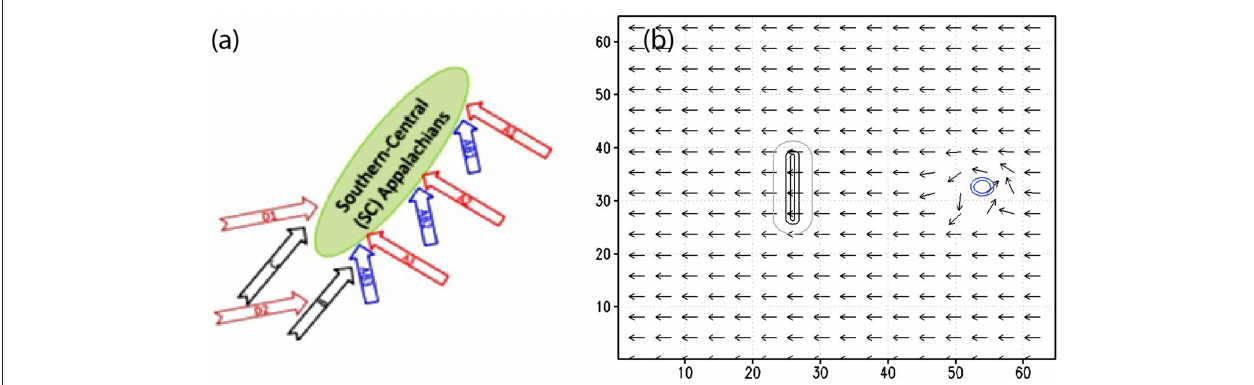
FIGURE 2 | (A) Detailed classification of tropical cyclone (TC) track types over the South-Central Appalachian (SCA) mountain range. (B) The entire computation domain with the mountain range, the wind flow and the initial bogus vortex. The units of the coordinates in the x and y directions are 100km. The mountain contours are 5, 400, and 600m. The vorticity contours are 5 × 10 − 5 s − 1 , and 1 × 10 − 4 s − 1